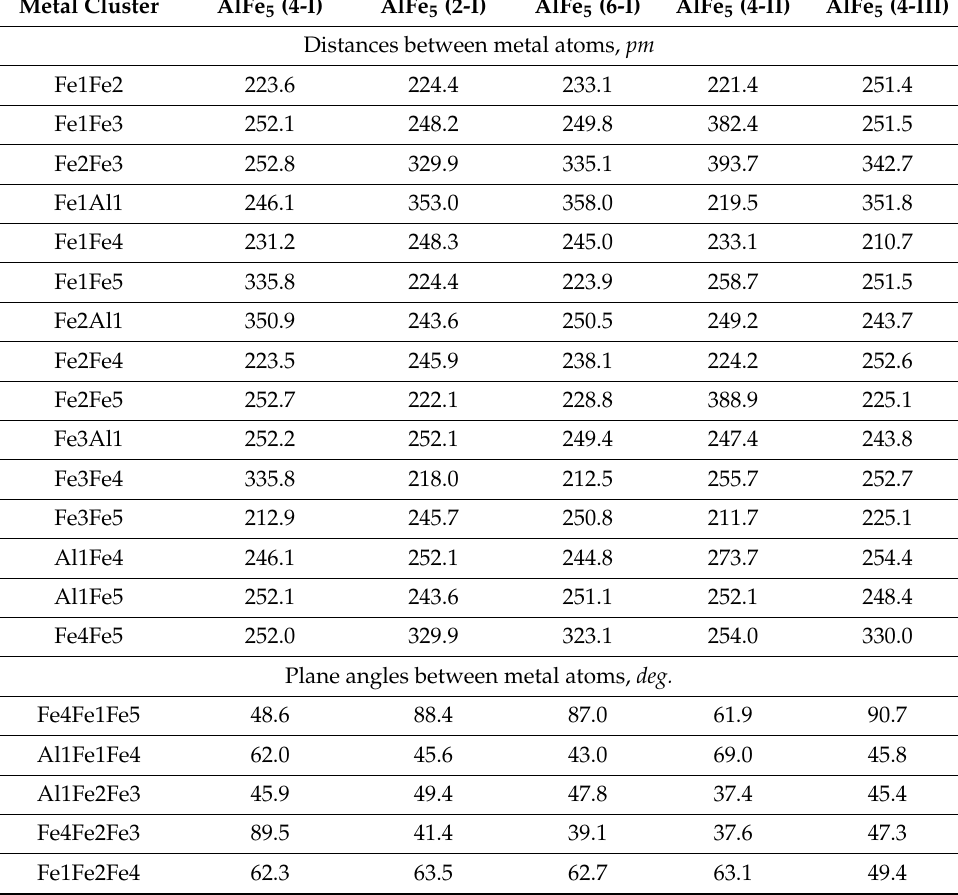
Table 10. Key structural parameters of the most stable AlFe 5 metal